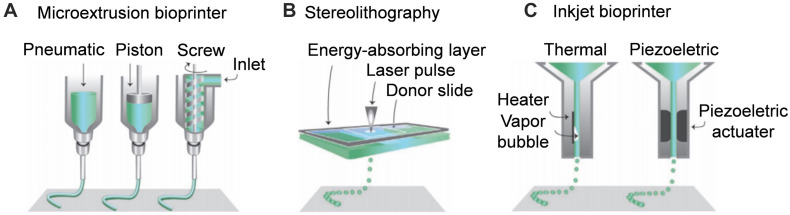
Schematic diagram of additive manufacturing techniques for nerve guide conduit. (A) Microextrusion bioprinter. (B) Stereolithography. (C) Inkjet bioprinter. Reproduced with permission from Malda et al. (2013).